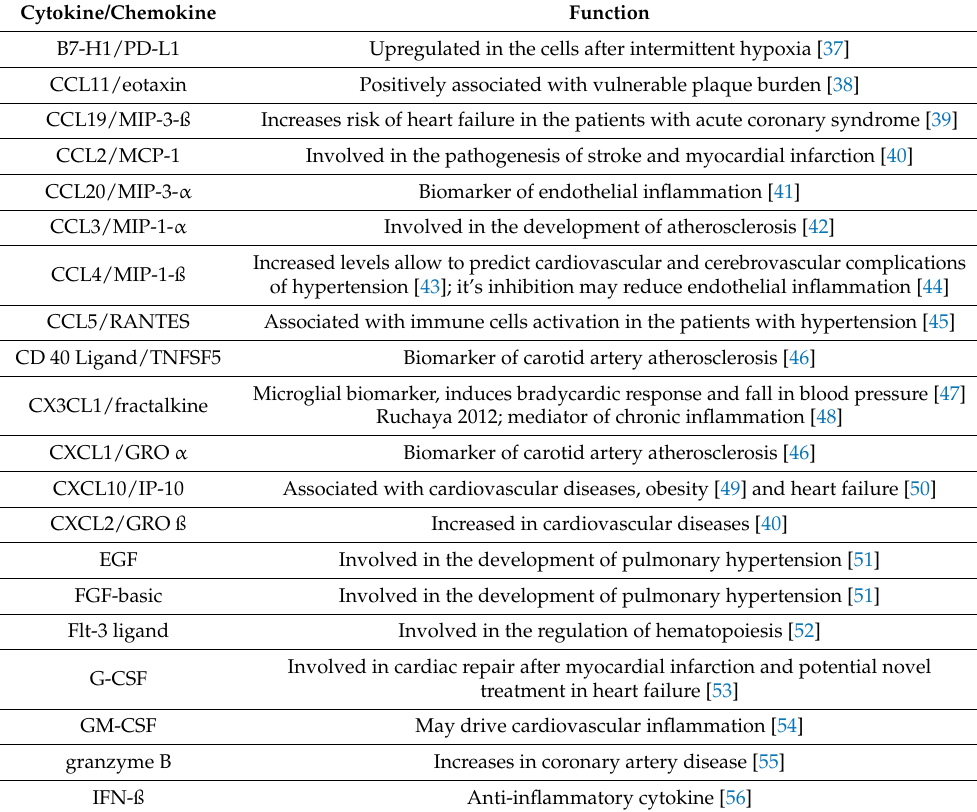
Table 3. The list of cytokines/chemokines with their function related to inflammation and cardiovas- cular